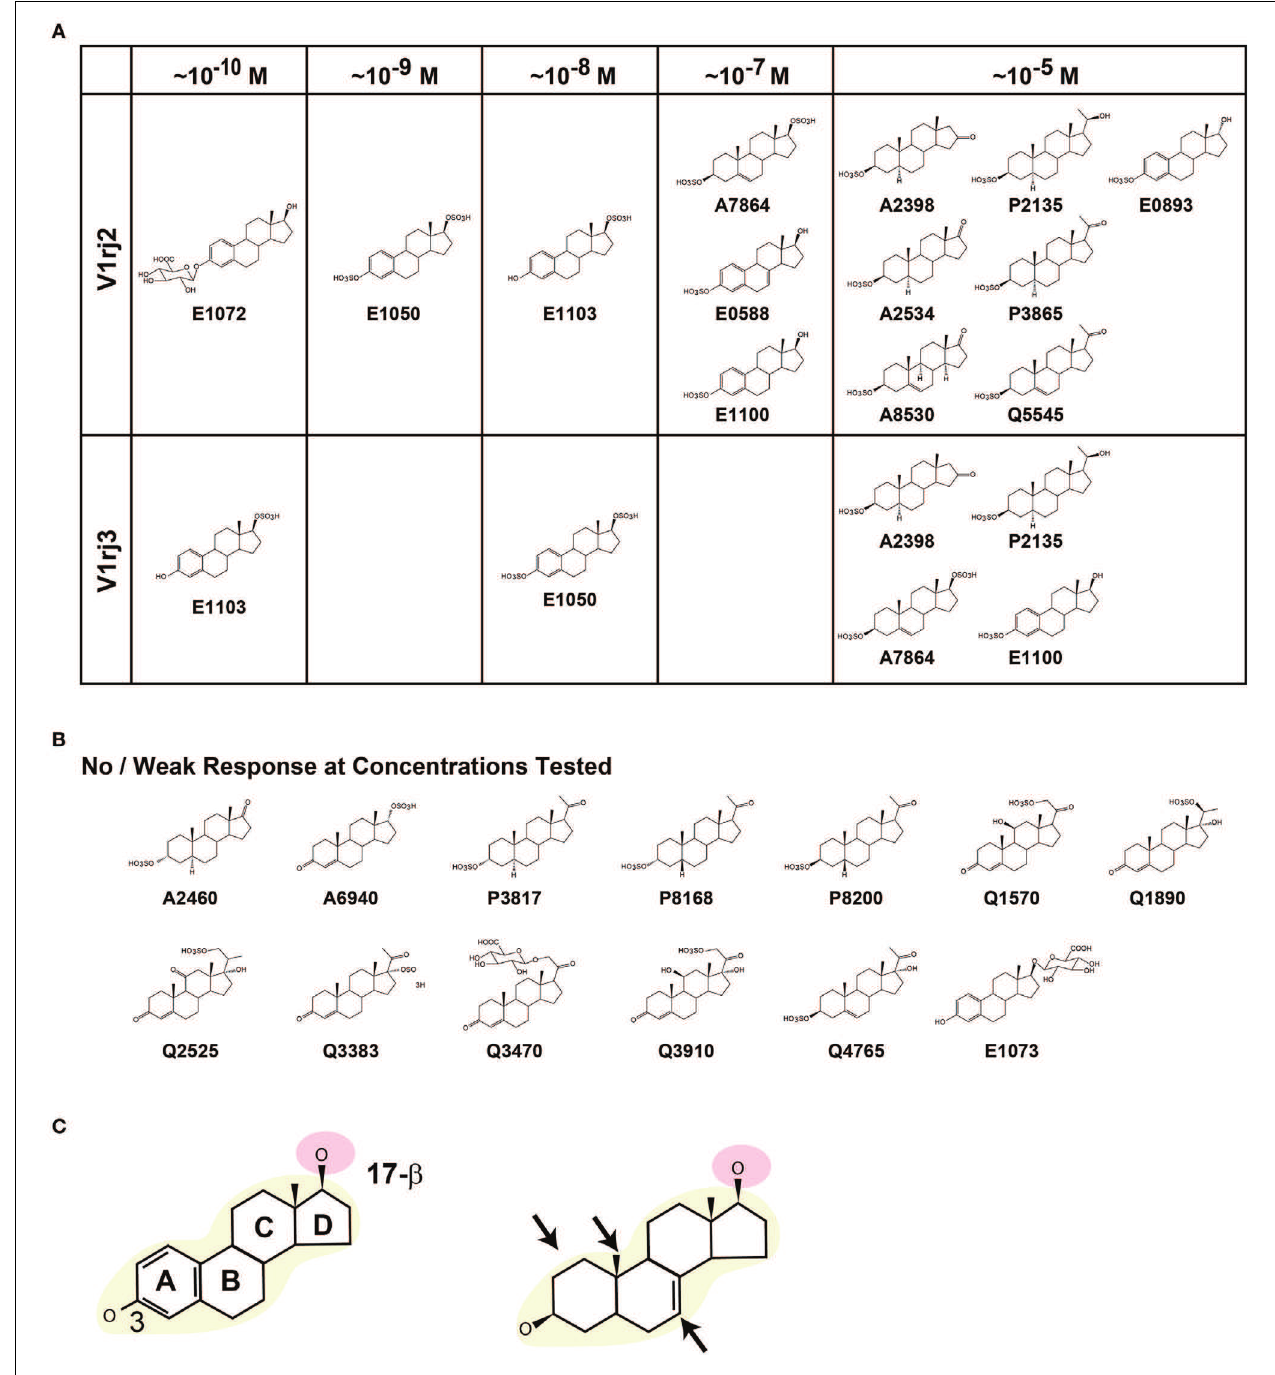
FIGURE 10 | Structural elements of steroid compounds that activate V1rj2 and V1rj3 receptors. (A) Steroid compounds that activate V1rj2 and V1rj3 receptors. The minimal concentrations of activation are indicated. (B) Molecular structures of sulfated or glucuronidated steroids that induce no or